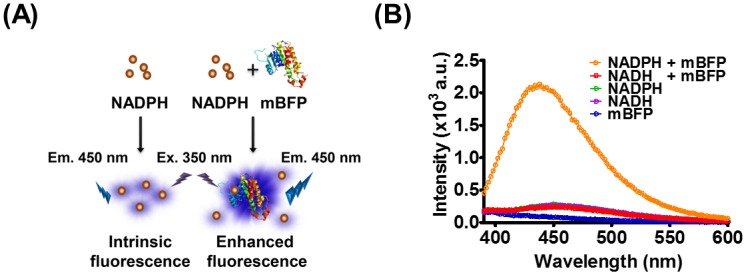
Enhancement of NADPH fluorescence upon its binding to mBFP.(A) Schematic representation of the interaction between NADPH and mBFP followed by immediate enhancement of fluorescence from the complex in comparison with weak fluorescence of free NADPH. (B) Comparison of fluorescence spectra. The emission spectrum between 380 and 600 nm was individually obtained upon irradiation of each solution with UV light at 350 nm wavelength.